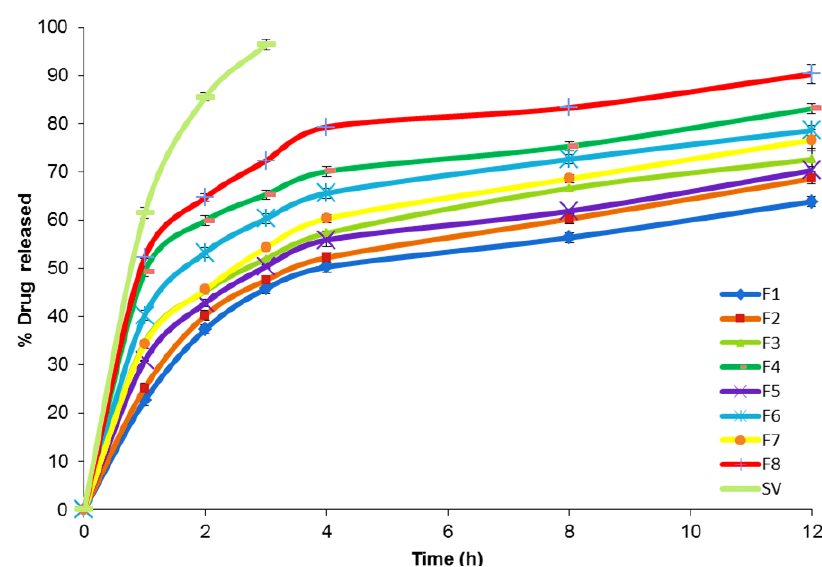
Figure 2. In vitro release profile of SV-loaded nanospanlastic vesicles through semi-permeable cellulose membrane for 12 h, ( n = 3). Abbreviations: SV, Sodium valproate.